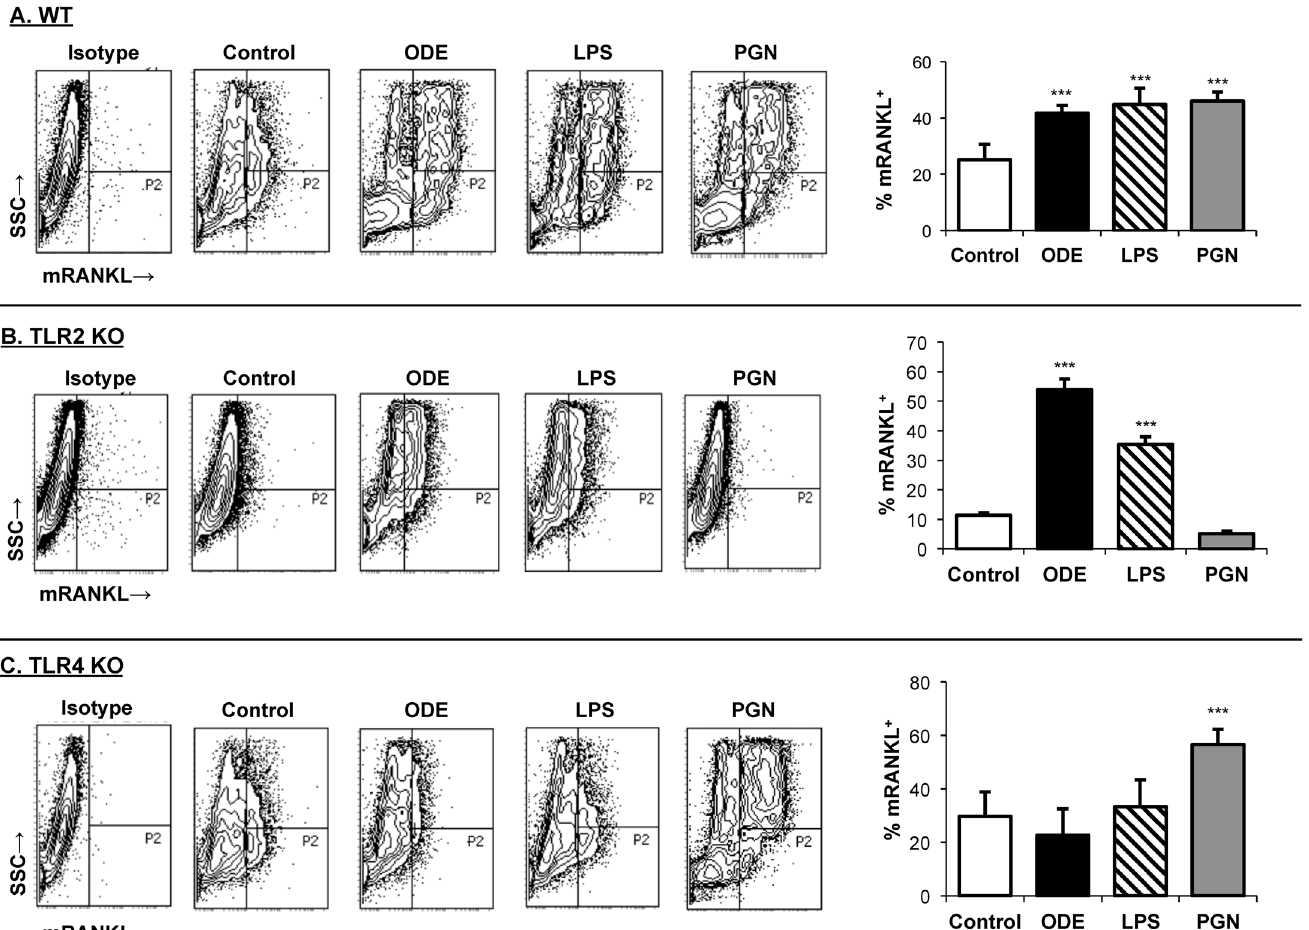
Fig 1. Organic dust extract (ODE) promotes osteoclastogenesis in vitro with WT and TLR2 KO, but not TLR4 KO, bone marrow macrophages. Bone marrow derived cells from C57BL/6 WT mice ( A, top panel ), TLR2 KO mice ( B, middle panel ), and TLR4 KO ( C, bottom panel ) were cultured with M-CSF and RANKL and ± ODE (0.5%). In side-by-side experiments, cells were also cultured with a TLR4 agonist (lipopolysaccharide; LPS; 10 ng) or TLR2 agonist (peptidoglycan; PGN; 1 μ g) as additional controls. Membrane receptor activator of NF- κ B ligand (mRANKL) expression was determined by flow cytometry analysis. A representative contour plot from each experimental group is shown with a rightward shift demonstrating gating of positive mRANKL expression after exclusion of debris. Bar graphs show the mean with standard error bars of percentage of mRANKL expression (P2 gate). N = 6/group from three separate studies ran in duplicate. Statistical significance denoted by asterisks ( *** p < 0.001) vs. unstimulated control.